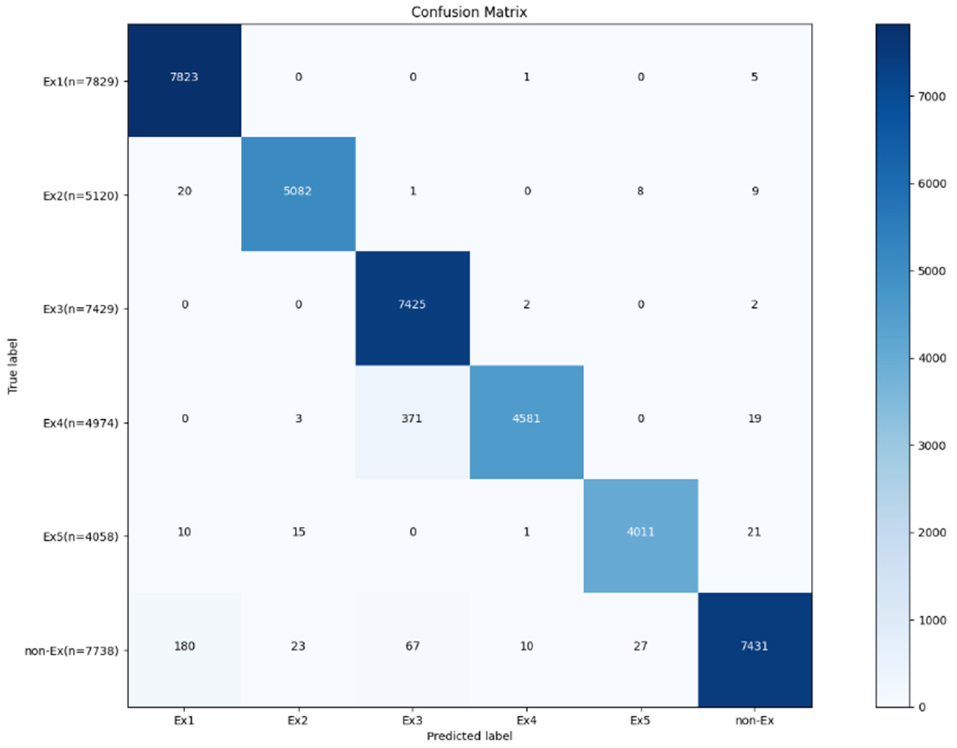
Figure A5. Goodness − of − fit of the overhead triceps extension 1 − RM equation models.